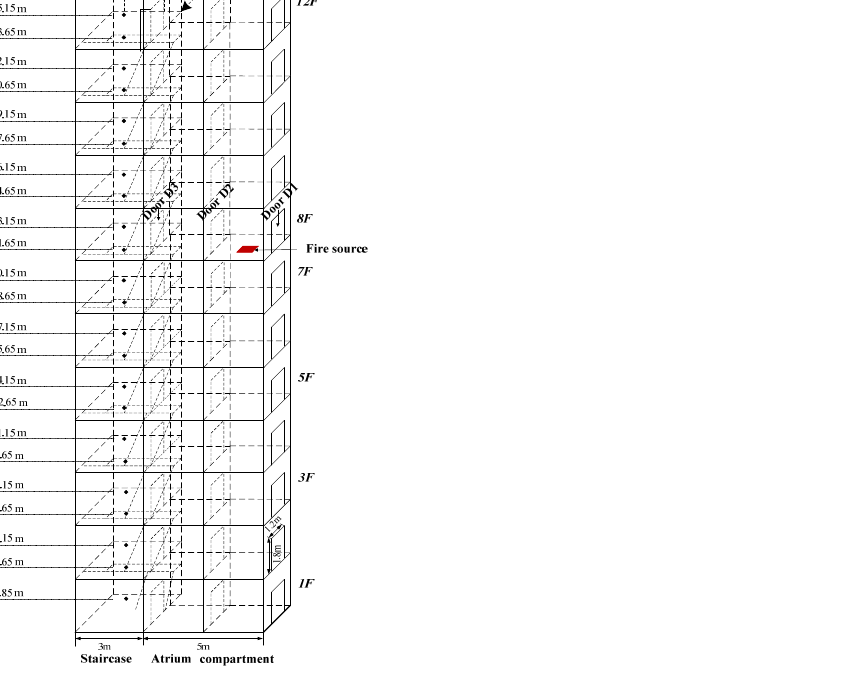
It is recommended by McGrattan et al. [20] that the value of D * = δ x should be in the range of 4–16. Then, the size of the finest mesh for a 2–4 MW fire was calculated to be between 0.07 and 0.4 m. Obviously, the finer grid will better reflect the heat flow field in detail, but it is also time-consuming. The mesh grid size was chosen to be 0.167 m in this study, which corresponds with previous studies [2,21,22]. To further verify the accuracy of the LES model, the vertical temperature distributions inside the staircase without external wind are compared with previous research [9,23], as shown in Figure 2. Qi et al. [24] researched the similarity laws between the full and small scales model and obtained the modified Froude–Stanton modeling. It can be expressed as